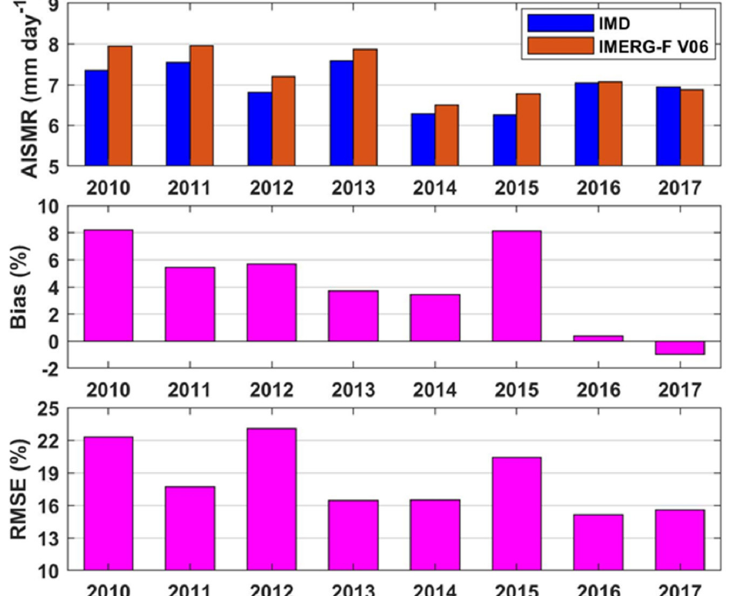
Figure 8. Interannual variations in all-India monsoon rainfall from the IMD rain-gauge-based dataset and IMERG-F version 6 estimates. Bias and root mean square errors in IMERG-F product for the same period against the rain-gauge-based dataset are also shown in the figure.